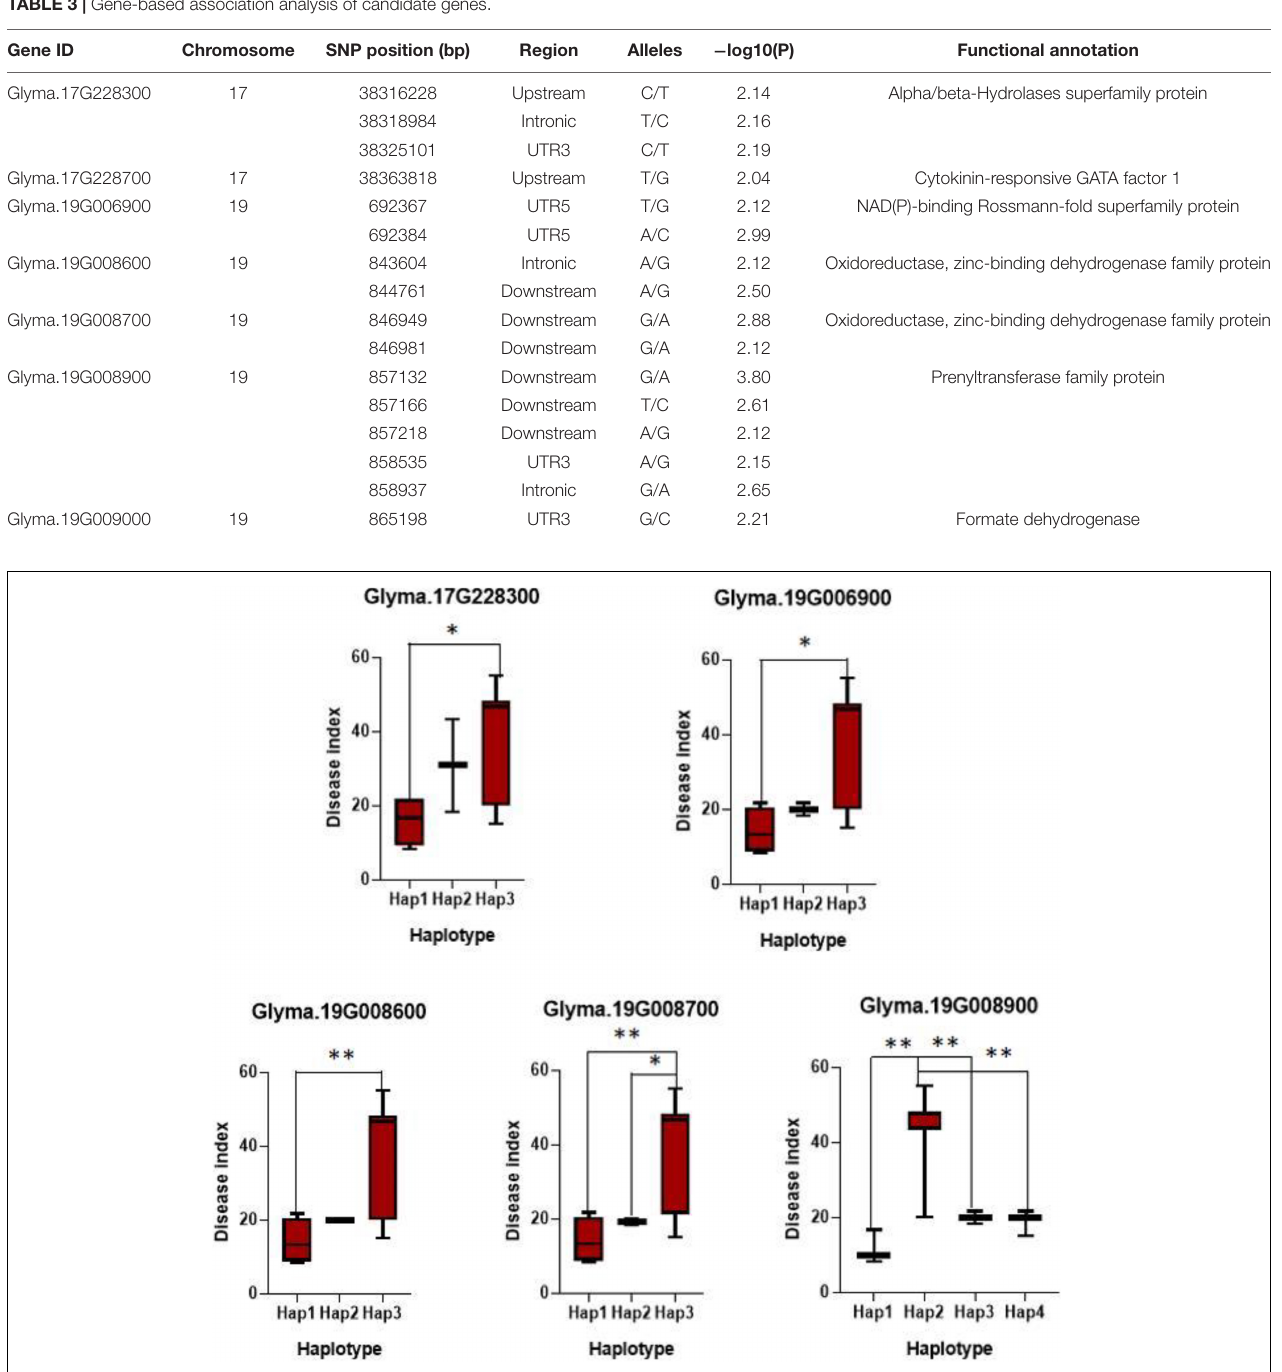
FIGURE 2 | Haplotypes analysis of genes with variations related with FLS race 1 resistance. The ∗ and ∗∗ suggested significance of ANOVA at p < 0.05 and p < 0.01, respectively.